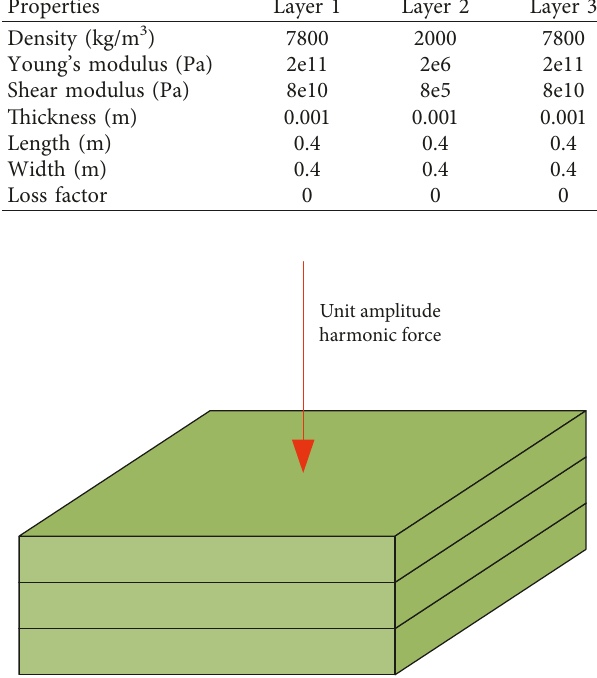
Figure 3: Unit amplitude harmonic force applied on the center of the multilayer plate.